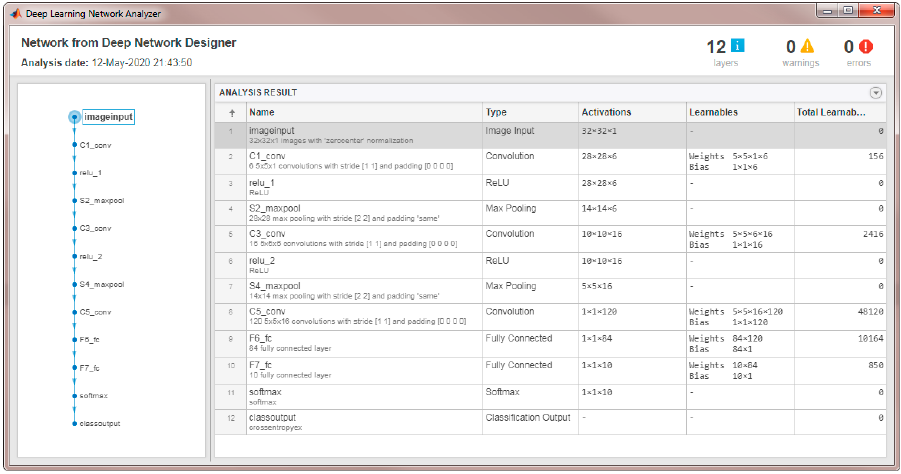
Figure 12. Analysis results of proposed CNN structure in MATLAB ® .